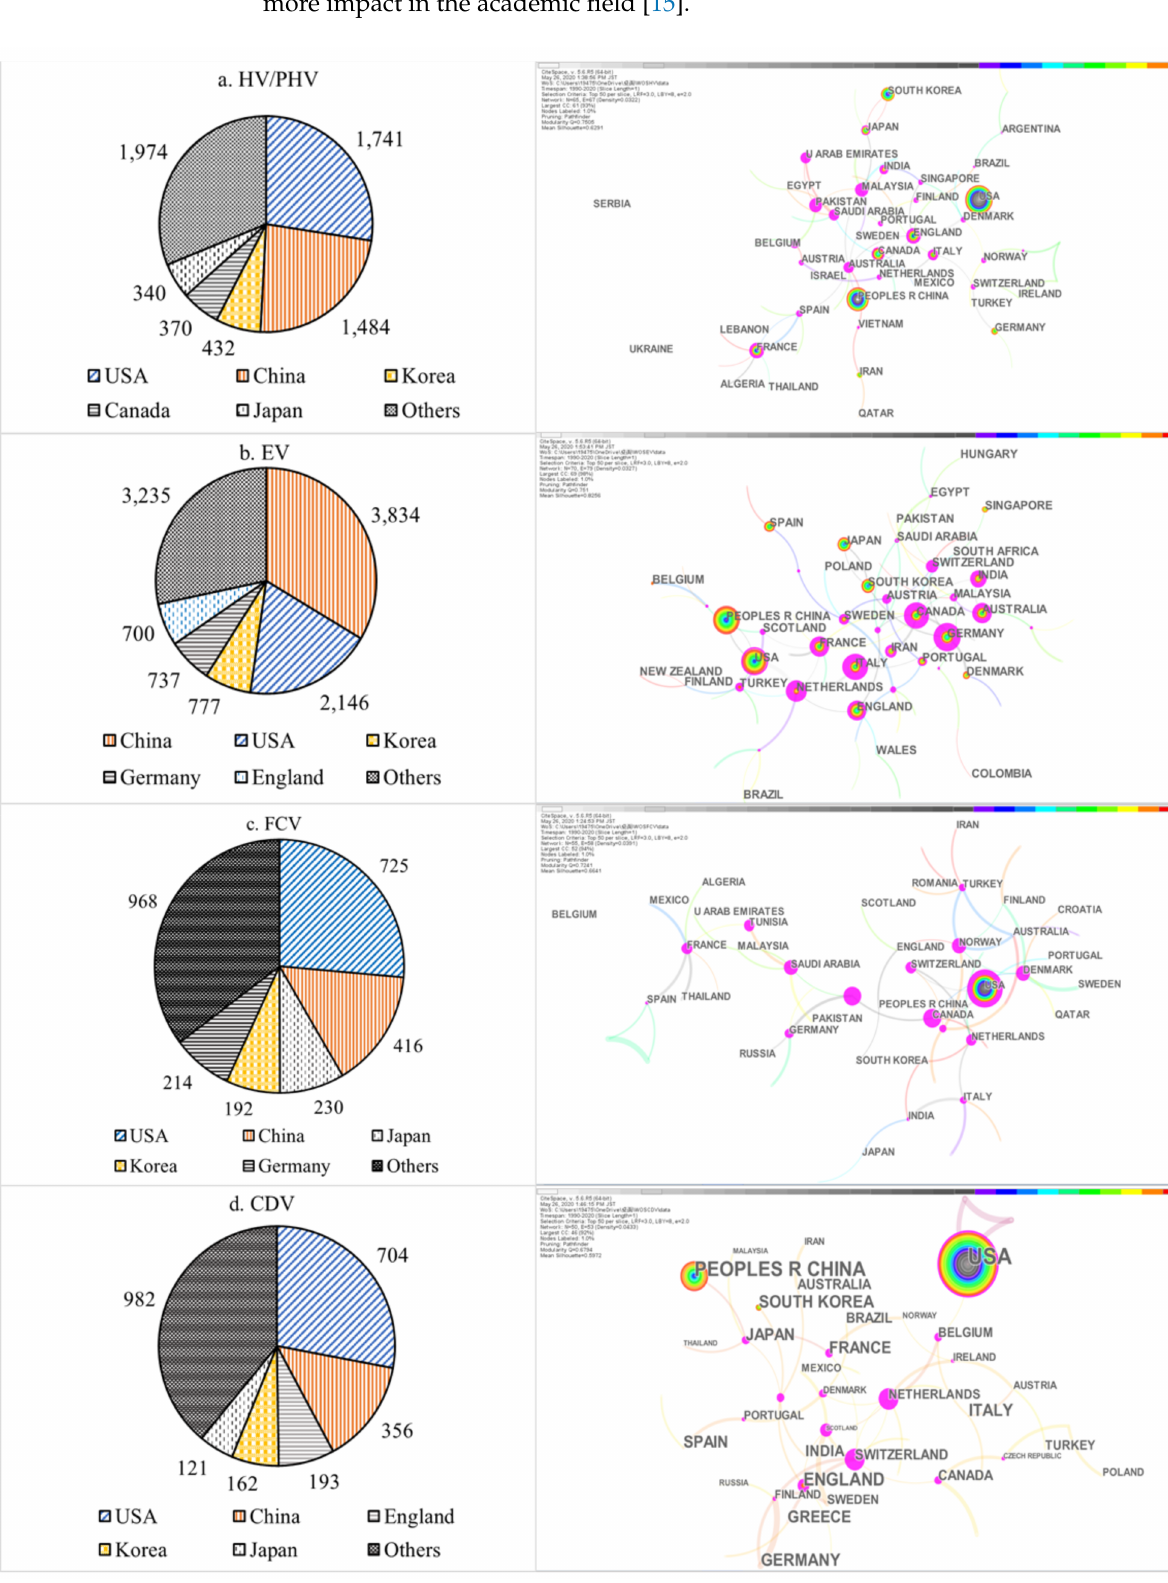
Figure 3. Country distribution of NGV